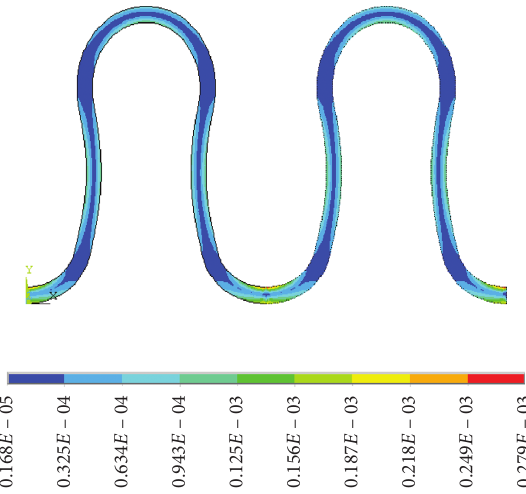
Figure 6: Strain distribution at air outlet and gas inlet side without considering thermal stress